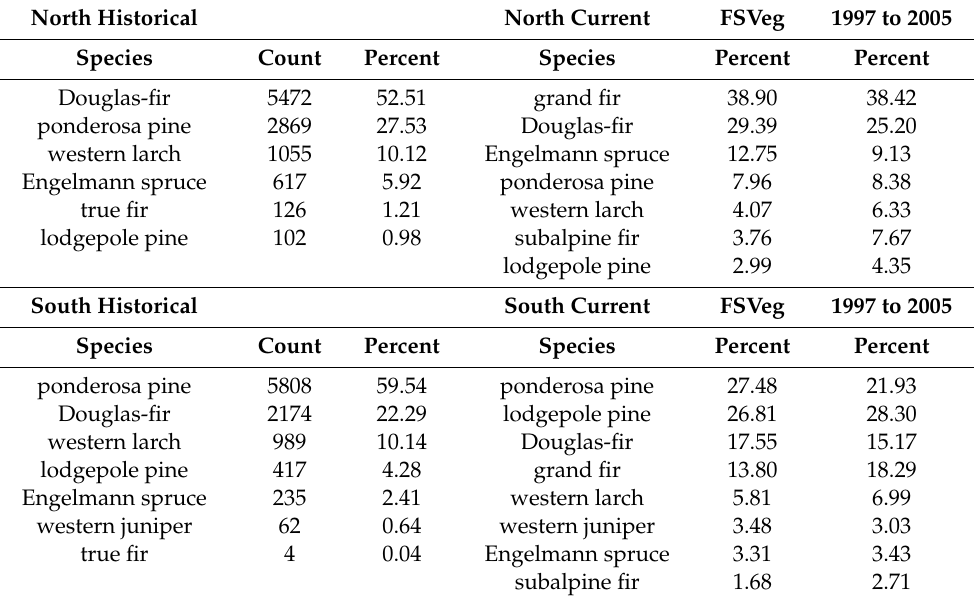
Table 3. Composition of historical bearing trees and current FSVeg imputation and 1997 to 2005 surveys for the north and south units of the Umatilla National Forest (if percent > 2 for any survey).